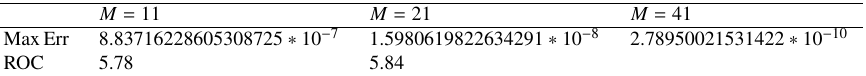
Table 2. Numerical results with the proposed method for Example 2.